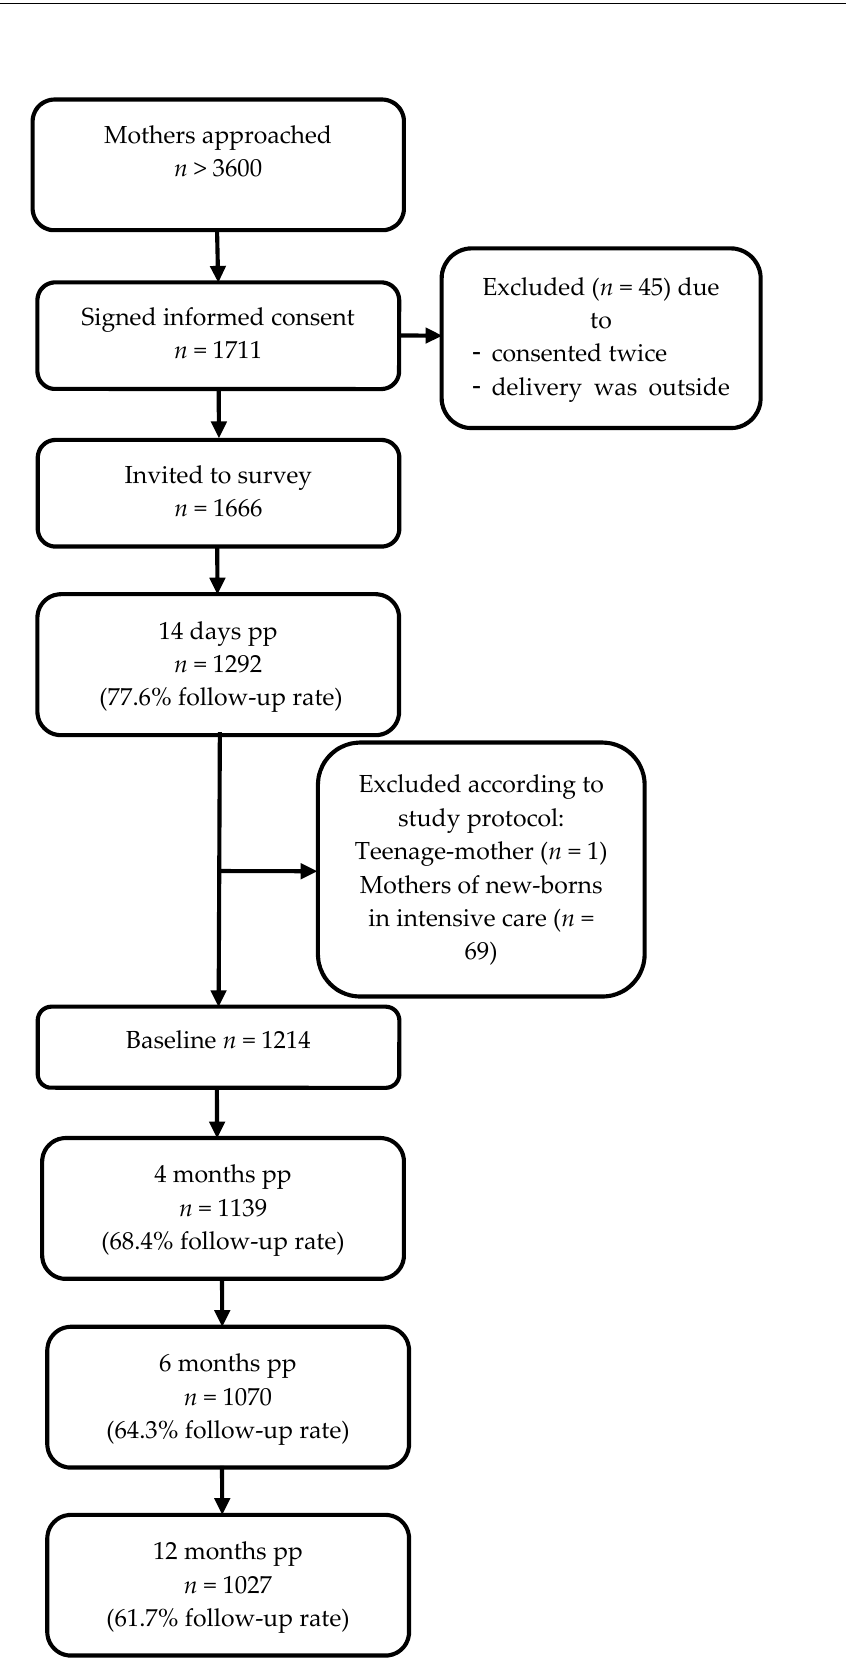
Figure 1. Flowchart of the sample selection process including follow-up rate of responding mothers (pp =